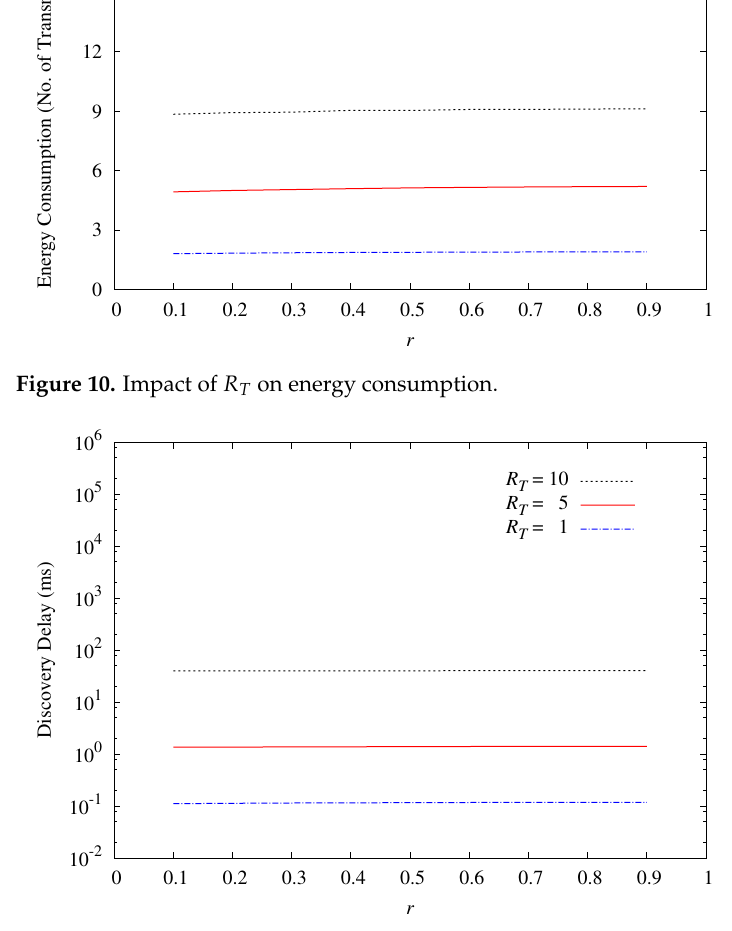
Figure 11. Impact of R T on discovery